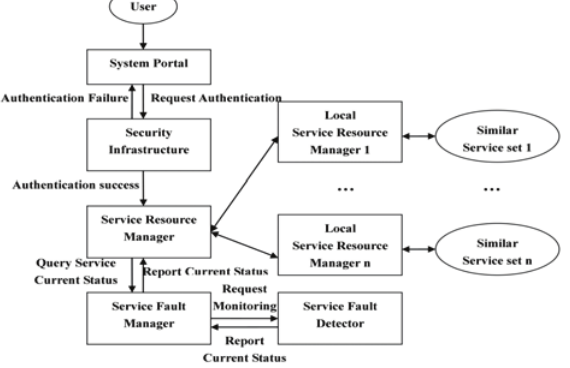
Fig. 1. Architecture of service migration